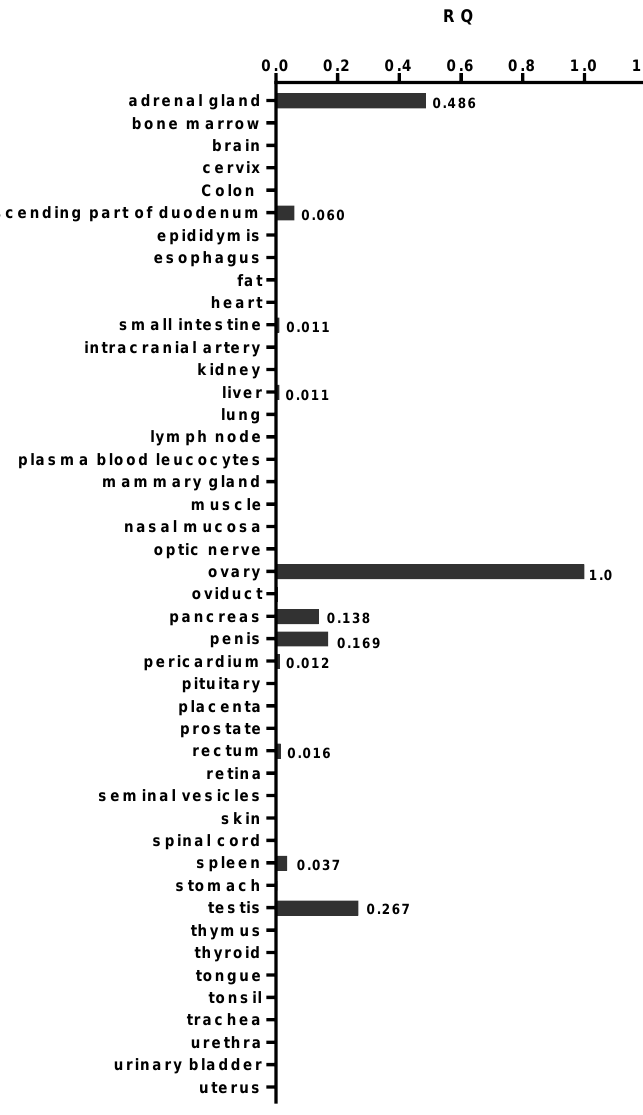
Figure 1. AMHRII expression in normal human tissues determined by RT-qPCR. Relative Quantification (RQ) values were calculated by using the delta Ct method.